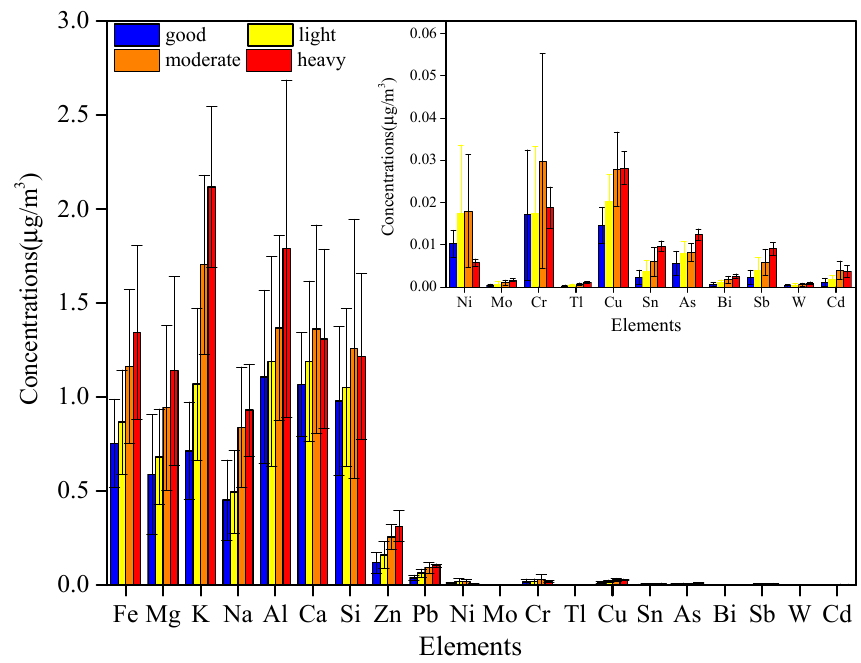
Figure 7. The concentrations of element compositions in four pollution days.